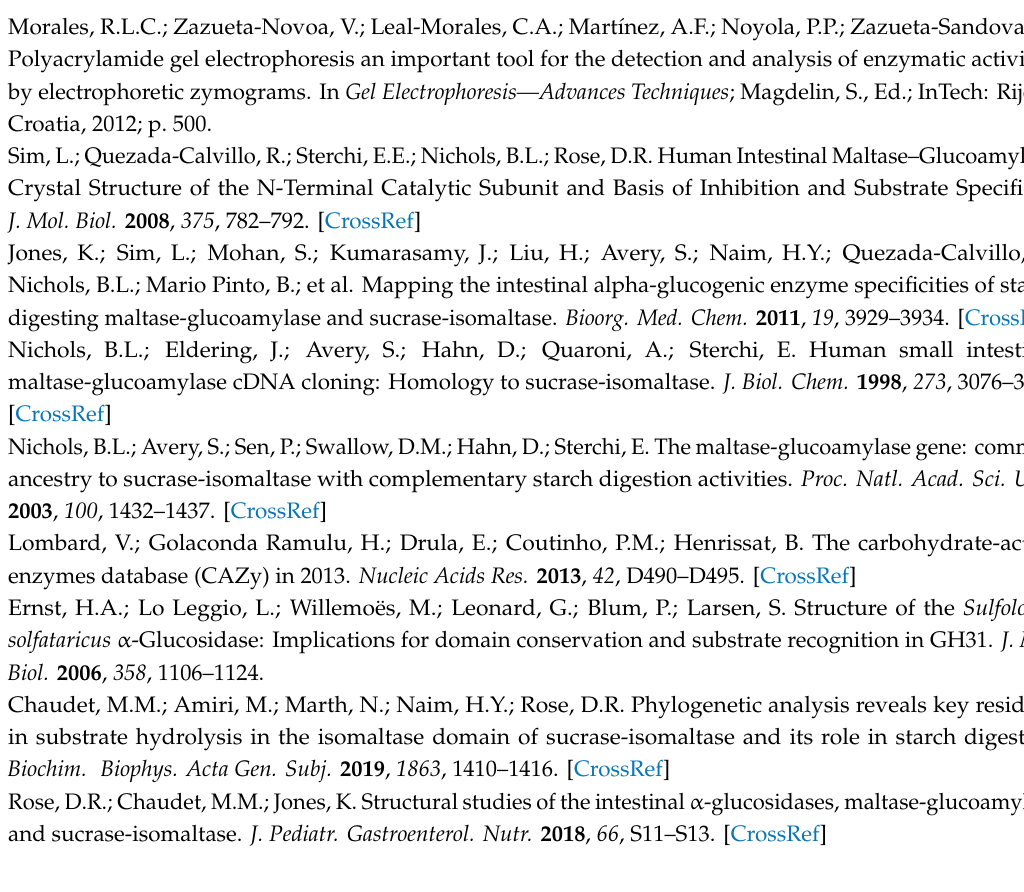
Table S1: Proteins identified by nano-liquid chromatography coupled to mass spectrometry in the slices cut from gels incubated with maltose and